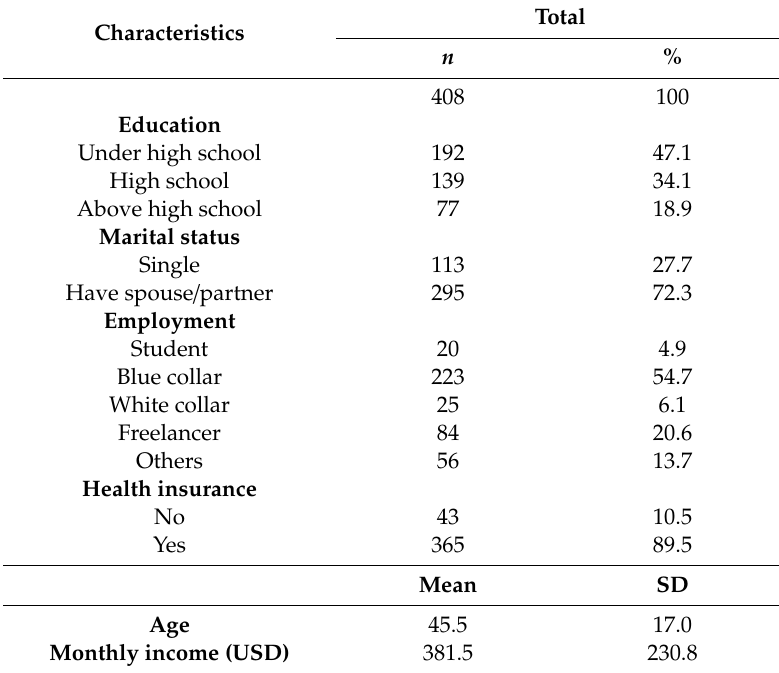
Table 1. Socioeconomic characteristics of